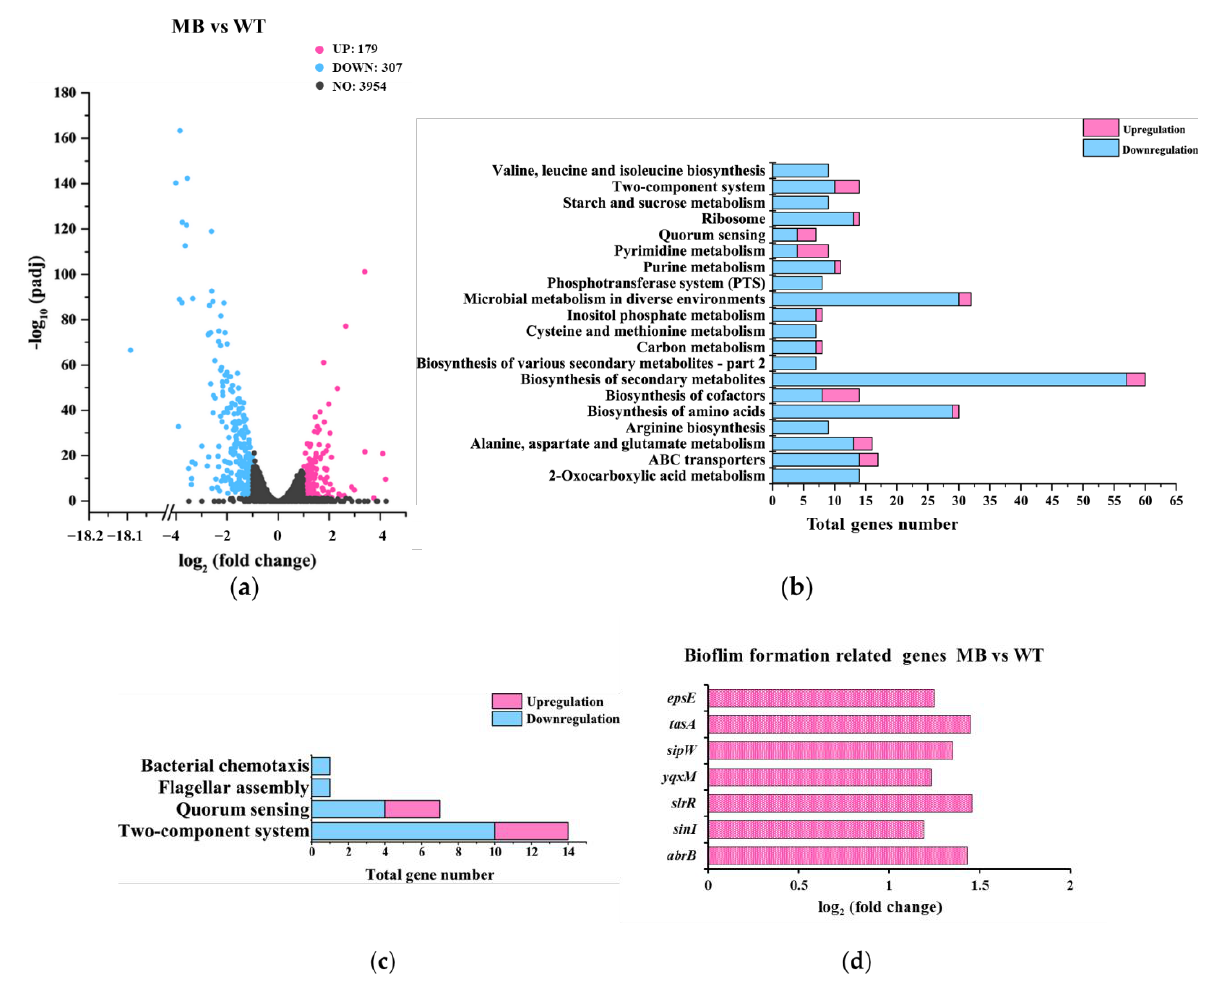
Figure 5. Analysis of the gene-expression differences between MB and WT. ( a ) A volcano plot showing the DEGs found in MB, compared with WT. DEGs were defined as the genes whose expression was up-regulated (pink dots) or down − regulated (blue dots) with a fold change of two or more ( p ≤ 0.05), when MB was compared with WT. Black dots represent genes without a significant change in expression. ( b ) Profiling of the DEGs via using the annotation of KEGG. ( c ) Grouping the DEGs by the indicated metabolic pathways. ( d ) Changes in the expression of the known biofilm-formation genes found as DEGs.